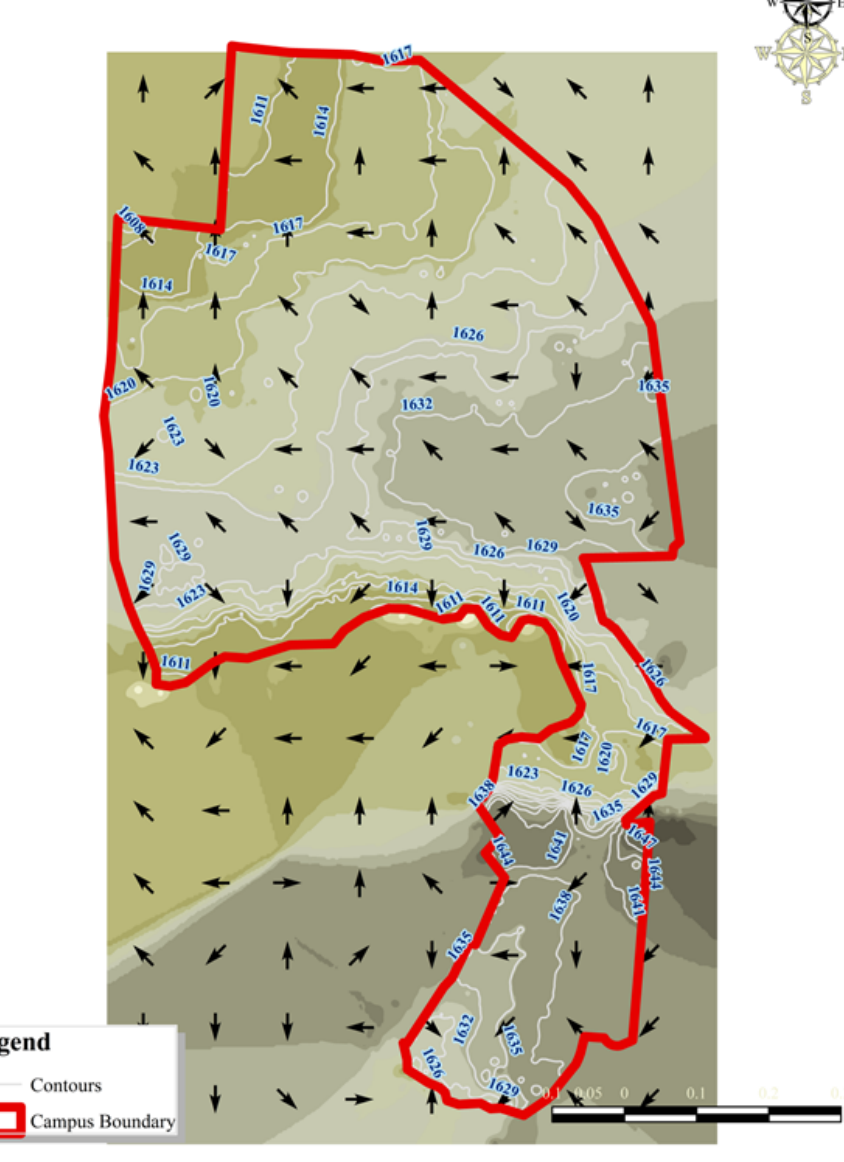
Figure 8. Contours and surface runoff flow direction